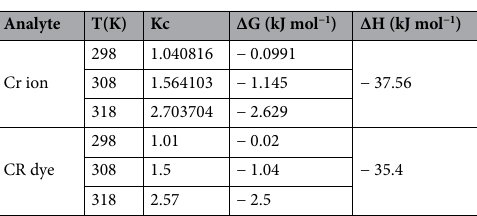
Table 3. Thermodynamic parameters for adsorption of Cr(VI) and CR-dye on the PMC material.